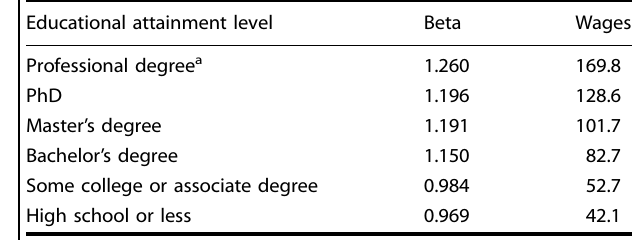
Table 3. 2019 power-law scaling exponents for MSA employment by educational attainment level vs. MSA size, with mean annual wages (in thousands of